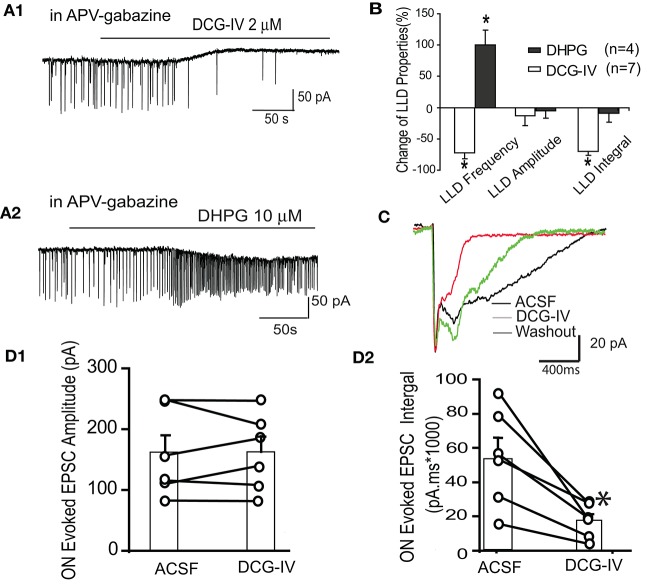
DCG-IV suppresses mitral cell spontaneous and ON-evoked LLDs. (A) Example mitral cell voltage clamp records (Vhold = −60 mV) in the presence of APV-gabazine show that DCG-IV (A1) suppresses while DHPG (A2) increases spontaneous LLDs. (B) Group data showing the effects of DCG-IV and DHPG on LLD properties. *p < 0.05 vs. respective control. (C) In normal ACSF, ON stimulation evoked a rapid monosynaptic EPSC followed by longer duration LLD. The LLD, but not the monosynaptic EPSC, was suppressed by DCG-IV (2 μm). (D1,2) Group data (n = 6) showing the effects of DCG-IV on the monosynaptic EPSC amplitude (D1) and the EPSC integral (D2); *p < 0.05 vs. control.